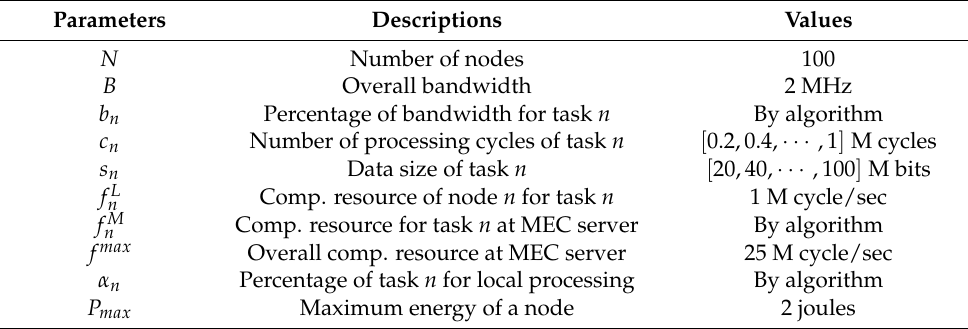
Table 1. Main notations in the model and their default values [23,29].